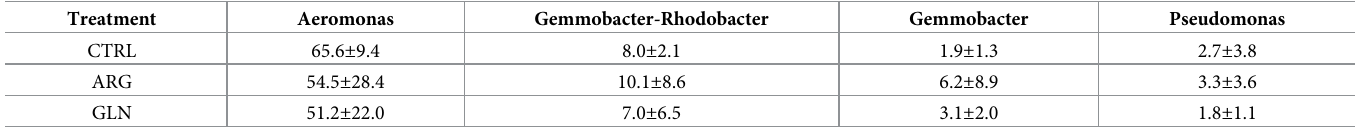
Values are means (%) of relative abundance ( ± SD). Table shows the four most abundant representatives’ genera. Gut microbiota at genus level of zebrafish larvae (22 dpf) from control (CTRL), arginine (ARG) and glutamine (GLN)